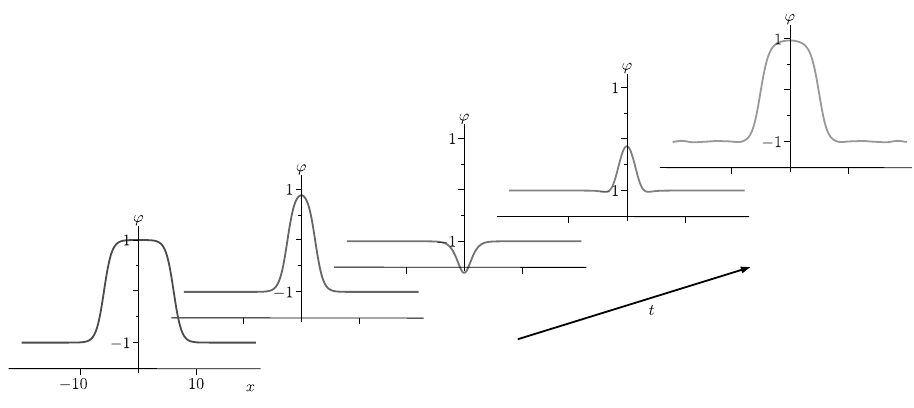
Figure 3.1: The profile of the field ϕ ( t , x ) for different values of t , as a kink and antikink collide. While the kinks attempt to pass through one another, kinetic energy is converted to potential energy in the field and the kinks slow down (three leftmost panels). The kinks then come to a halt (middle panel) and reverse direction, moving away from each other again (two rightmost panels). Some of the initial kineteic energy is radiated away in the form of small ripples (top right panel). For low initial velocities, the outmoving kinks may not have sufficient kinetic energy to escape to infinity, and a bion is formed